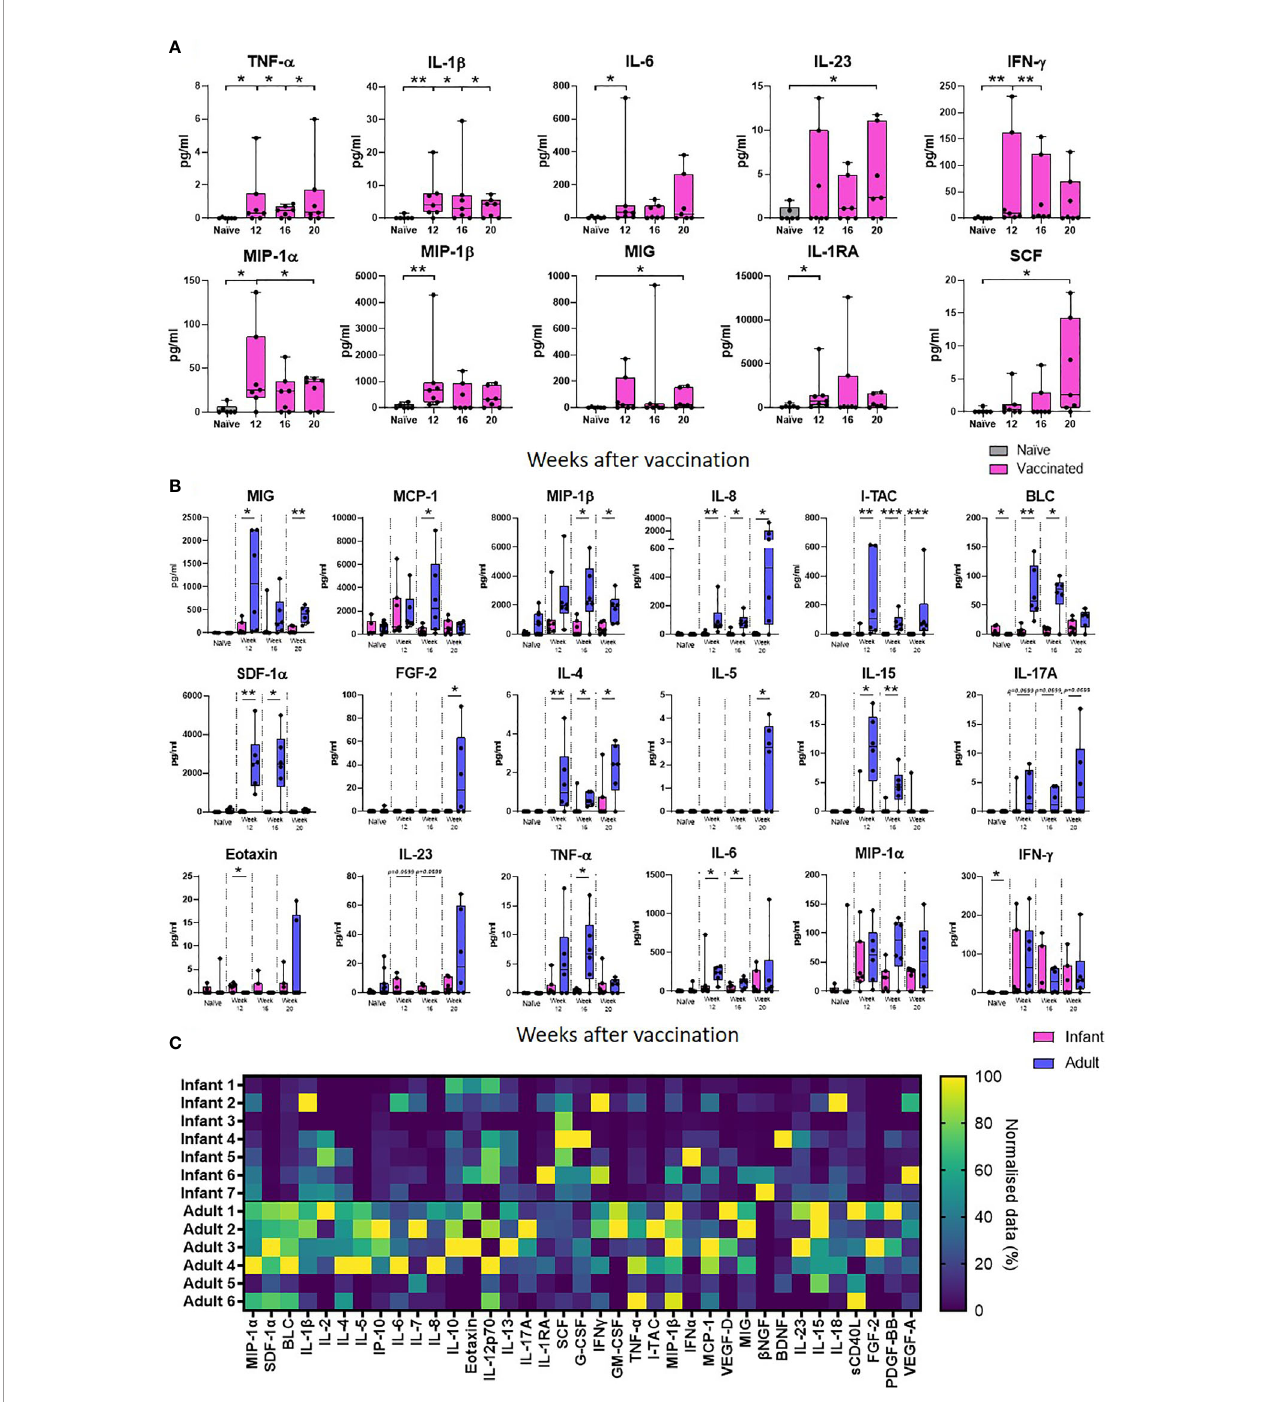
FIGURE 3 | PPD-speci fi c secretion of cytokine, chemokine and growth factor biomarkers measured in whole blood culture supernatant. Box plots (A) show the group median titre of each cytokine, chemokine or growth factor +/- the inter-quartile range measured in naïve (grey) infant macaques or at weeks 12, 16 and 20 after vaccination (pink), with minimum and maximum values connected by whiskers. Box plots (B) show the group median titre of each cytokine, chemokine or growth factor +/- the inter-quartile range measured in naïve infant macaques (pink) or naïve adult macaques (blue) at 12, 16 and 20 weeks after vaccination in each age group, with minimum and maximum values connected by whiskers. Dots represent individual animals. Signi fi cant differences measured by Mann-Whitney U-test between the groups are indicated. *p ≤ 0.05, **p < 0.01, ***p < 0.001. (C) . Quantity of PPD-speci fi c secretion of cytokine, chemokine and growth factor biomarkers between weeks 12 and 20 (AUC) in stimulated supernatants in macaques vaccinated as infants and adults in a heat map plot. Data was normalized to give a proportional (%) representation of AUC values calculated from the pro fi le of each analyte relative to the maximal amount of each analyte